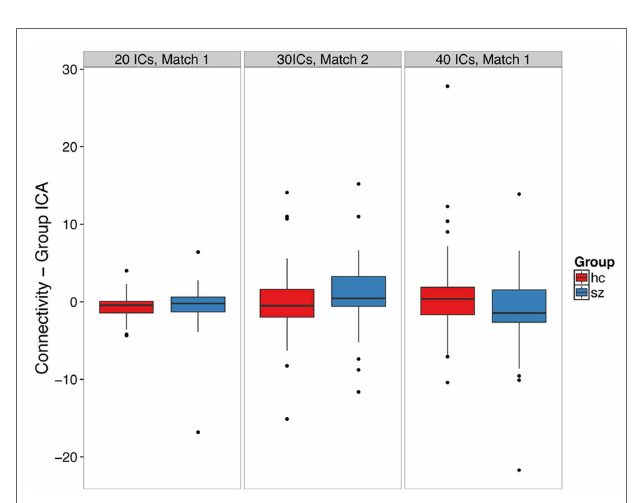
Figure 2 | hippocampal connectivity with the default mode network in schizophrenia patients and healthy controls . (a) Results from group level ICA 20 component analysis. (B) Results from individual subject level ICA analysis with automatically determined number of components. Statistical maps displayed at p < 0.001,